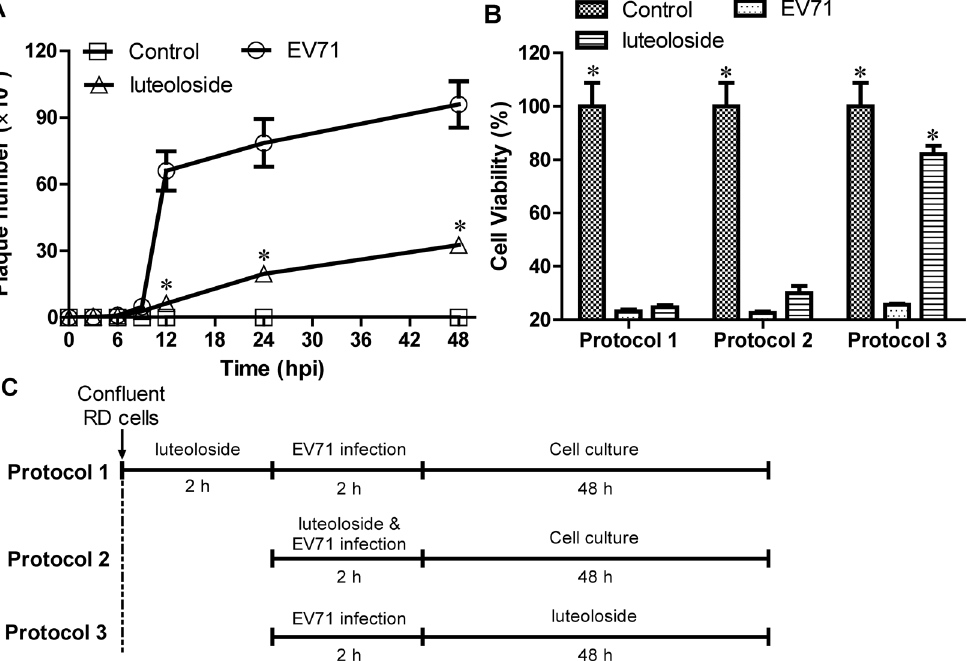
Fig 4. Luteoloside reduced EV71 production. (A) RD cells grown in 6-well-plate were infected with EV71 (MOI = 0.3) in the presence or absence of 0.5 mM luteoloside. The intercellular and extracellular virions were collected at the indicated time points for plaque reduction assay by freeze-thawing. (B) RD cells were infected with EV71 (MOI = 0.3). 0.5 mM luteoloside were supplemented to infected RD cells according to different protocols (C) respectively. The cell viability was detected using MTS cell proliferation assay kit at 48 hpi. The viability of control group was set as 100%. Data shown are the means ± SE from 6 independent measurements ( n = 6). Asterisk meant the data differed from the EV71 group significantly at P < 0.05 level according to t